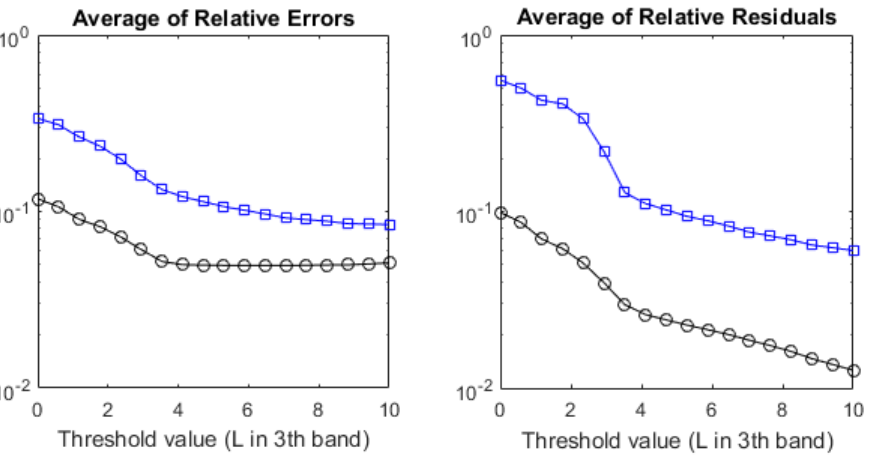
Figure 8. Evolution of the discrepancies between hyperspectral and multispectral temperatures (black circles) and column densities (blue squares), measured as average relative error ( left ) and average residuals ( right ), for the stoichiometric ( φ = 1) standard flame, as a function of the radiance threshold, measured in W/m 2 · sr · cm − 1